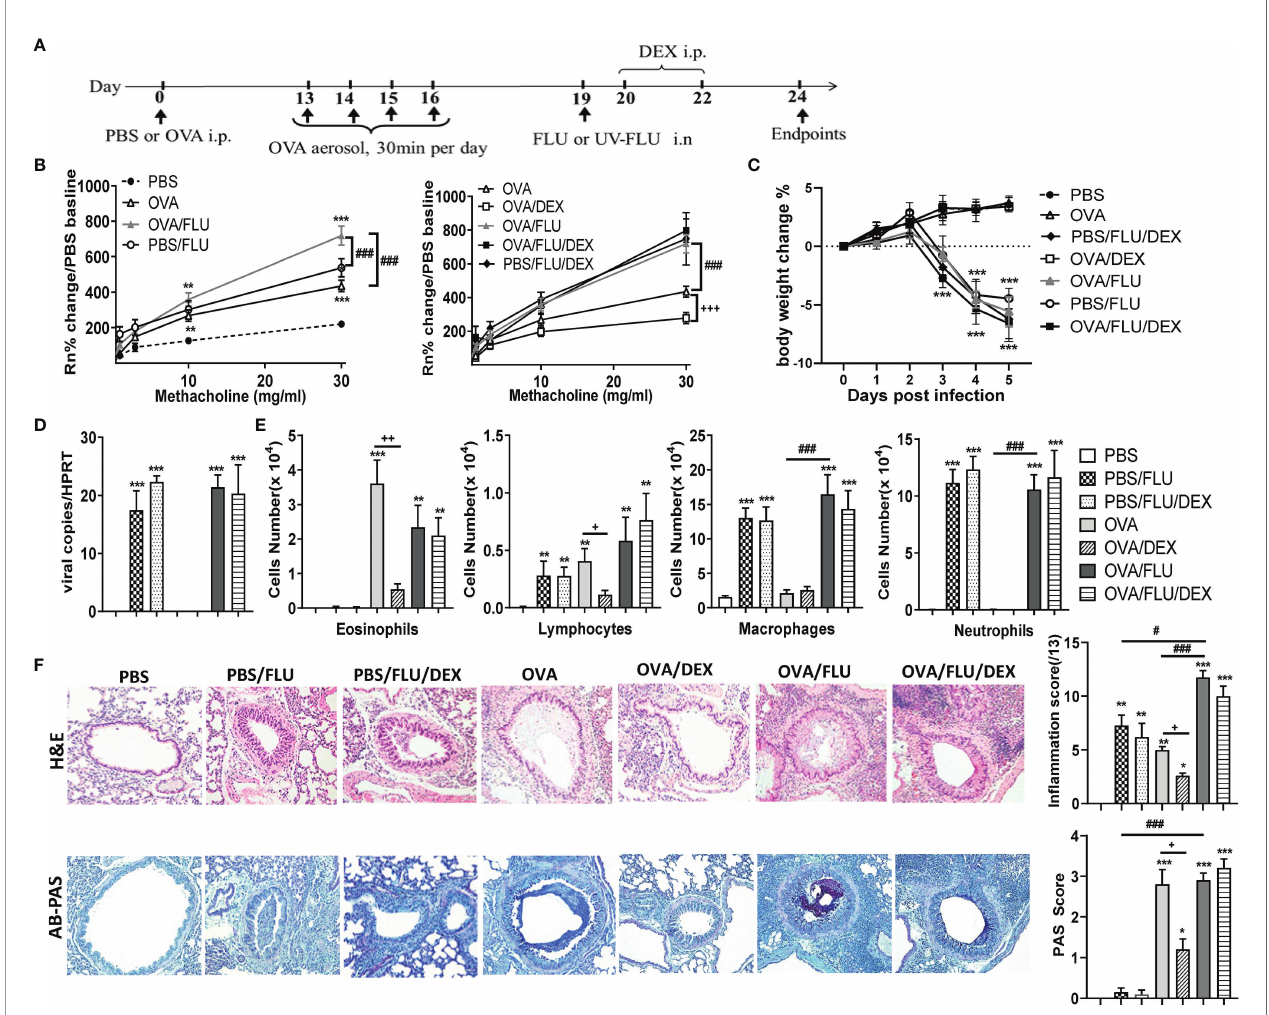
FIGURE 1 | Viral infection of allergic asthmatic mice induces increased airway hyperresponsiveness (AHR) and in fl ammation which does not respond to dexamethasone (DEX) treatment. BALB/c mice were sensitized i.p. with OVA/PBS on day 0 and exposed to OVA aerosol on days 13 – 16. Some mice were inoculated with FLU on day 19 and/or treated with DEX on days 20 and 22, and lung function and airway in fl ammation were assessed on day 24. (A) experimental design; (B) AHR; (C) body weight changes over 0 dpi; (D) viral load in lung tissue assessed by qPCR; (E) differential in fl ammatory cell counts for eosinophils, lymphocytes, macrophages, and neutrophils in BALF; (F) histologic examination of lungs stained with H& E for assessment of in fl ammatory score or AB-PAS for assessment of mucus-secreting goblet cells hyperplasia. All images were randomly selected using a 20 × magni fi cation lens. Data are presented as mean ± SEM (n = 6-8 mice/group) and are representative of three independent experiments. *Designates signi fi cant differences compared to PBS group (*p < 0.05, **p < 0.01, ***p < 0.001); #Designates signi fi cant differences compared to OVA/FLU treated group (#p < 0.05, ###p < 0.001); +Designates signi fi cant differences compared to DEX treated groups (+p < 0.05, ++p < 0.01, +++p <